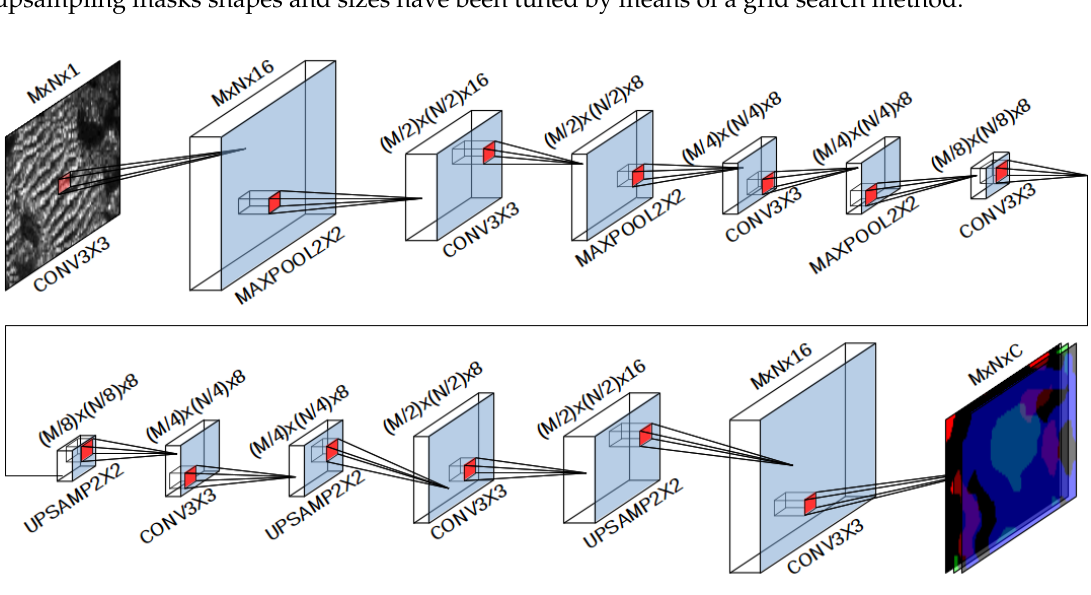
Figure 5. The Neural Network